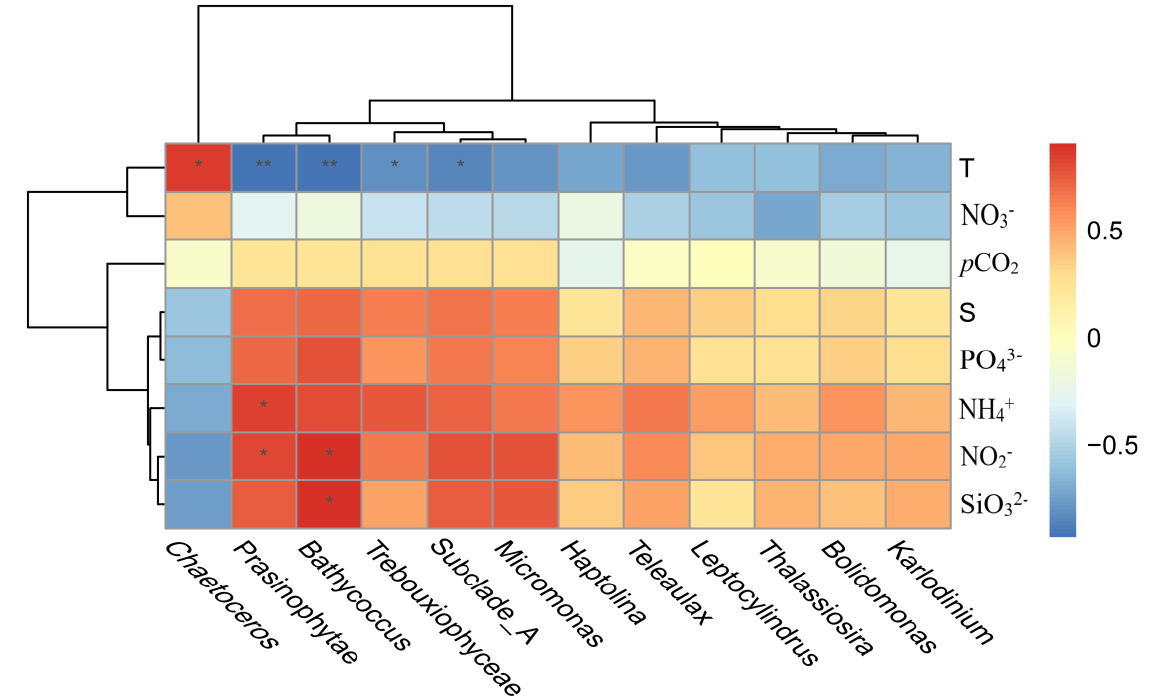
Figure 6. Spearman correlation matrix of eukaryotic microalgae algae genera and environmental parameters. Colors indicate correlation coefficients, with red indicating a positive correlation, and blue indicating a negative correlation. “*” represents significant correlation ( p < 0.05) and “**” represents highly significant correlation ( p <